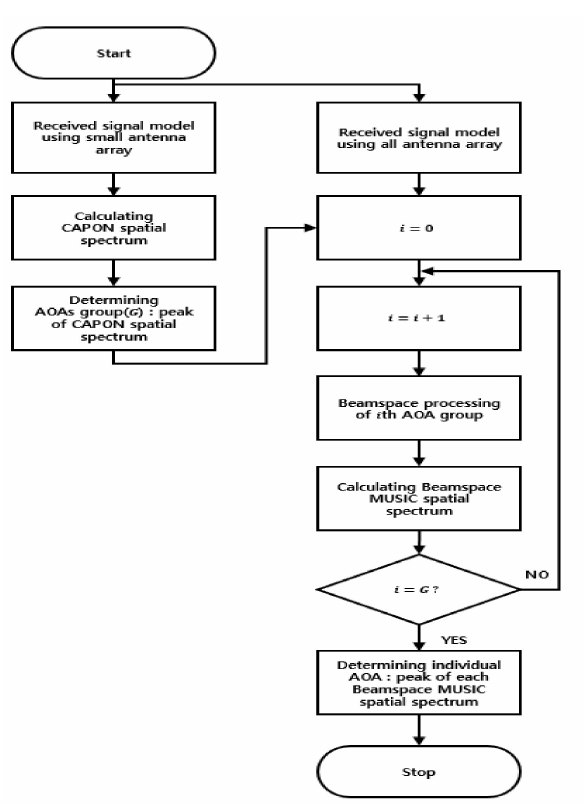
Figure 3. Flow chart of the proposed cascade